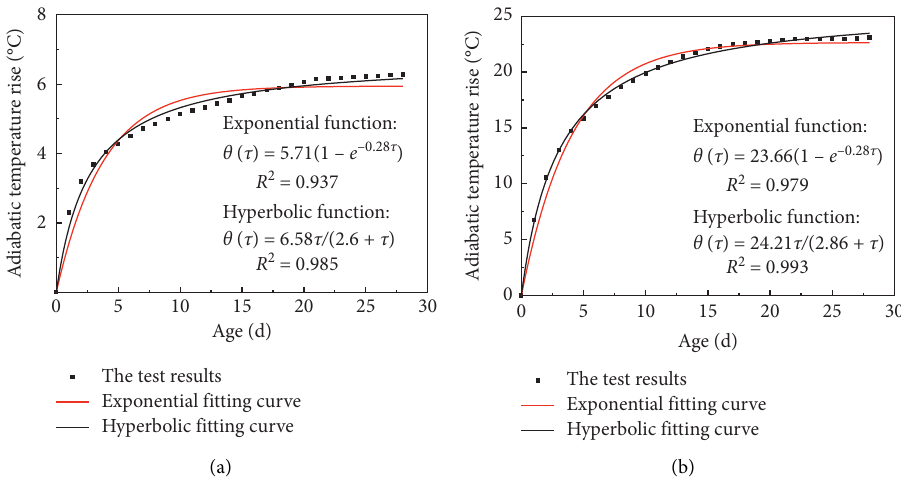
Figure 6: Adiabatic temperature rise curve fitting with different cementing agent content. (a) 40 kg/m 3 . (b) 140kg/m 3 . Table 3: Adiabatic temperature rise expression of different cementing agent content. Cementing agent content (kg/m 3